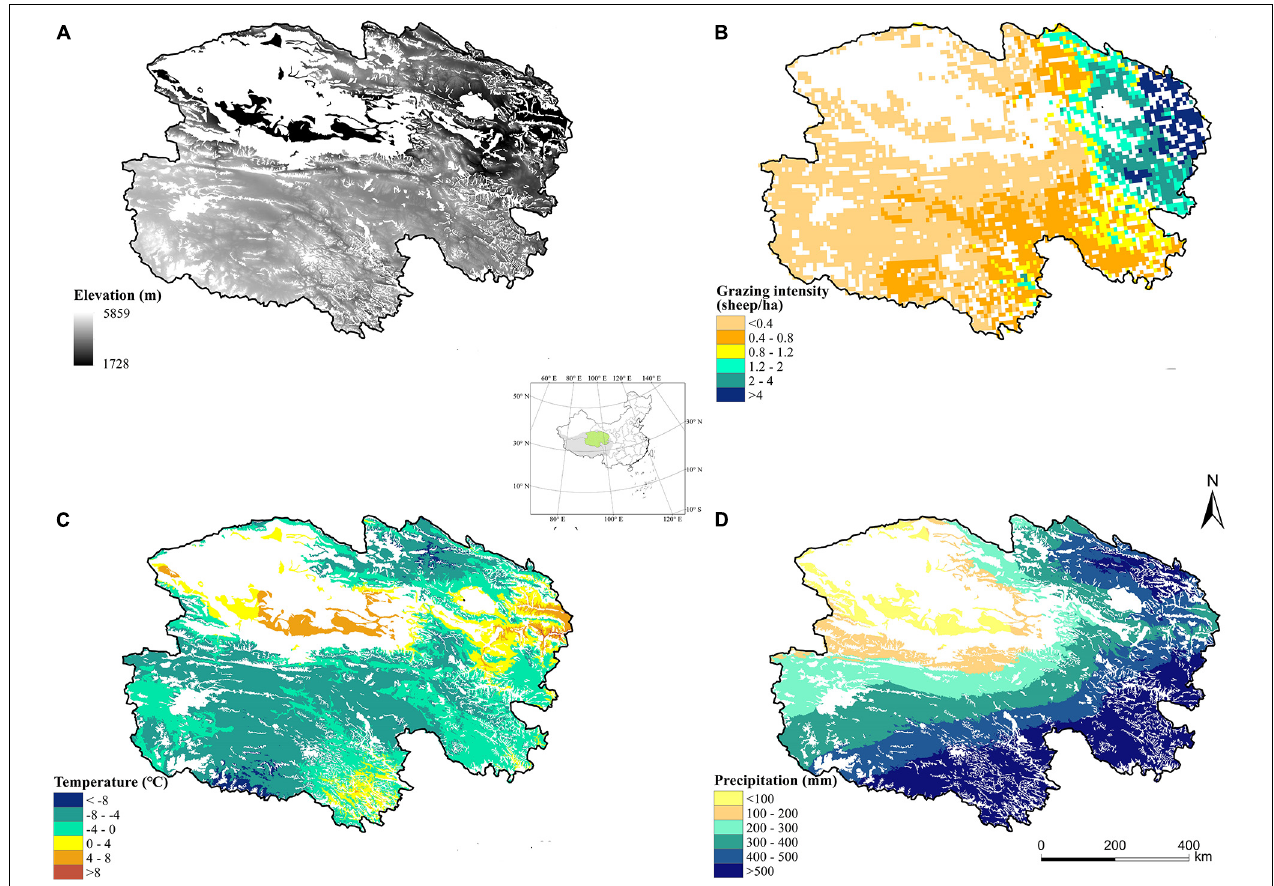
FIGURE 1 | Elevation (A) , average annual grazing intensity (B) , average annual temperature (C) , and average annual precipitation (D) in Qinghai grasslands from 1979 to